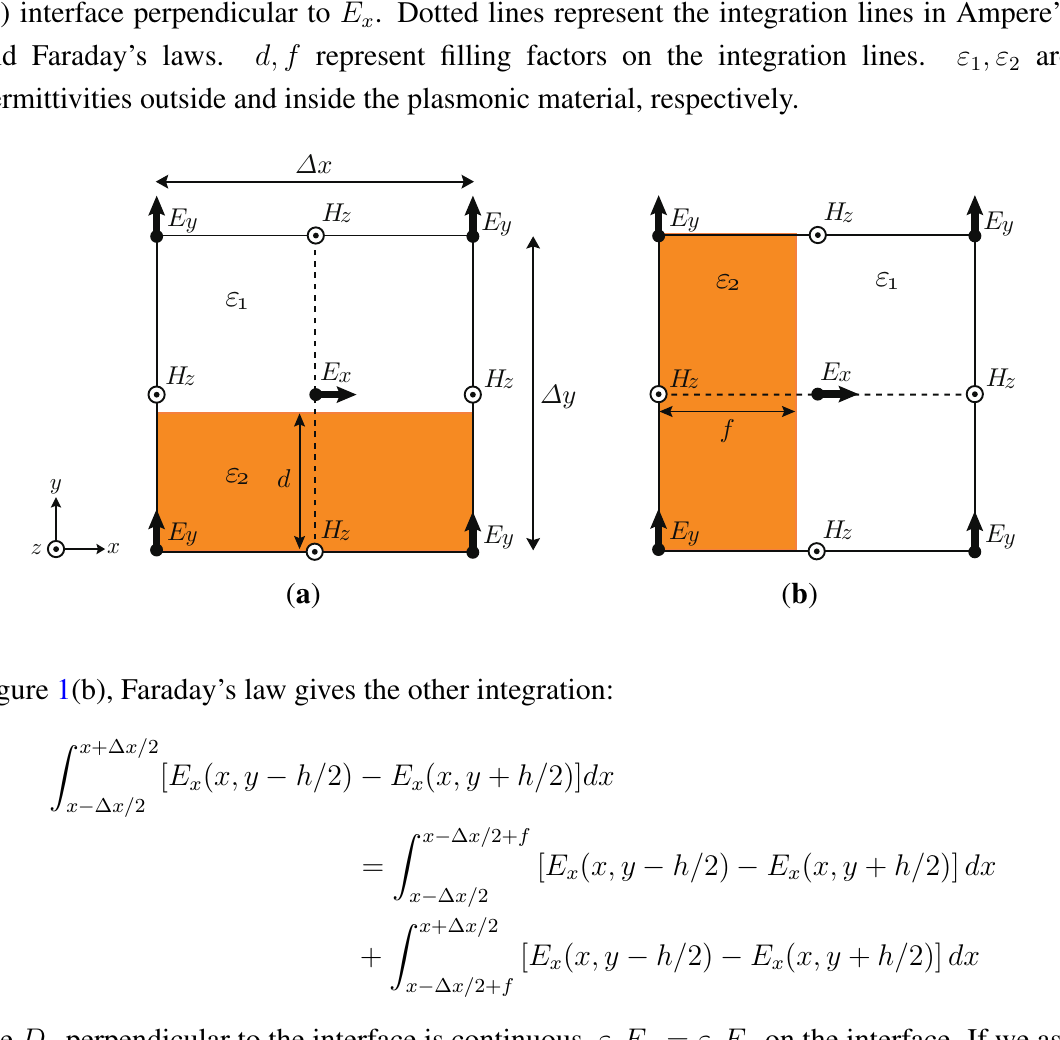
. Dotted lines represent the integration lines in Ampere’s x